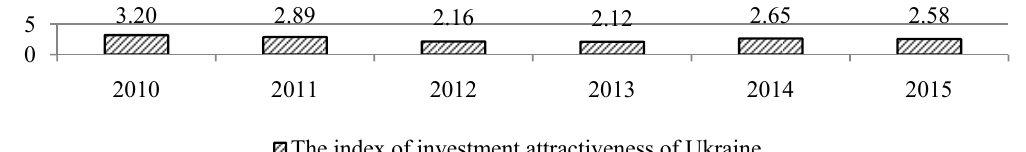
Fig. 3. The index of investment attractiveness of Ukraine in 2010-2015 (European Business Association)